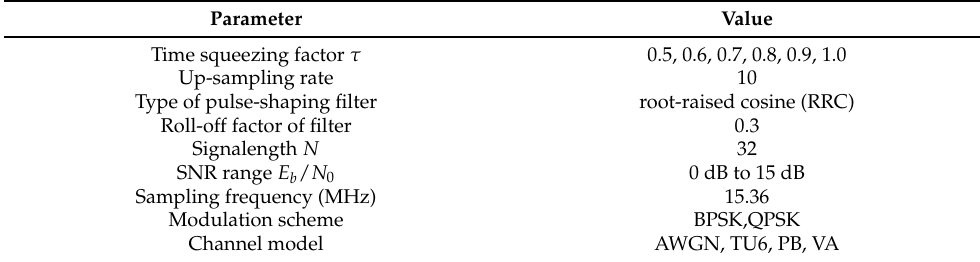
Table 1. Experimental settings for FTN signaling